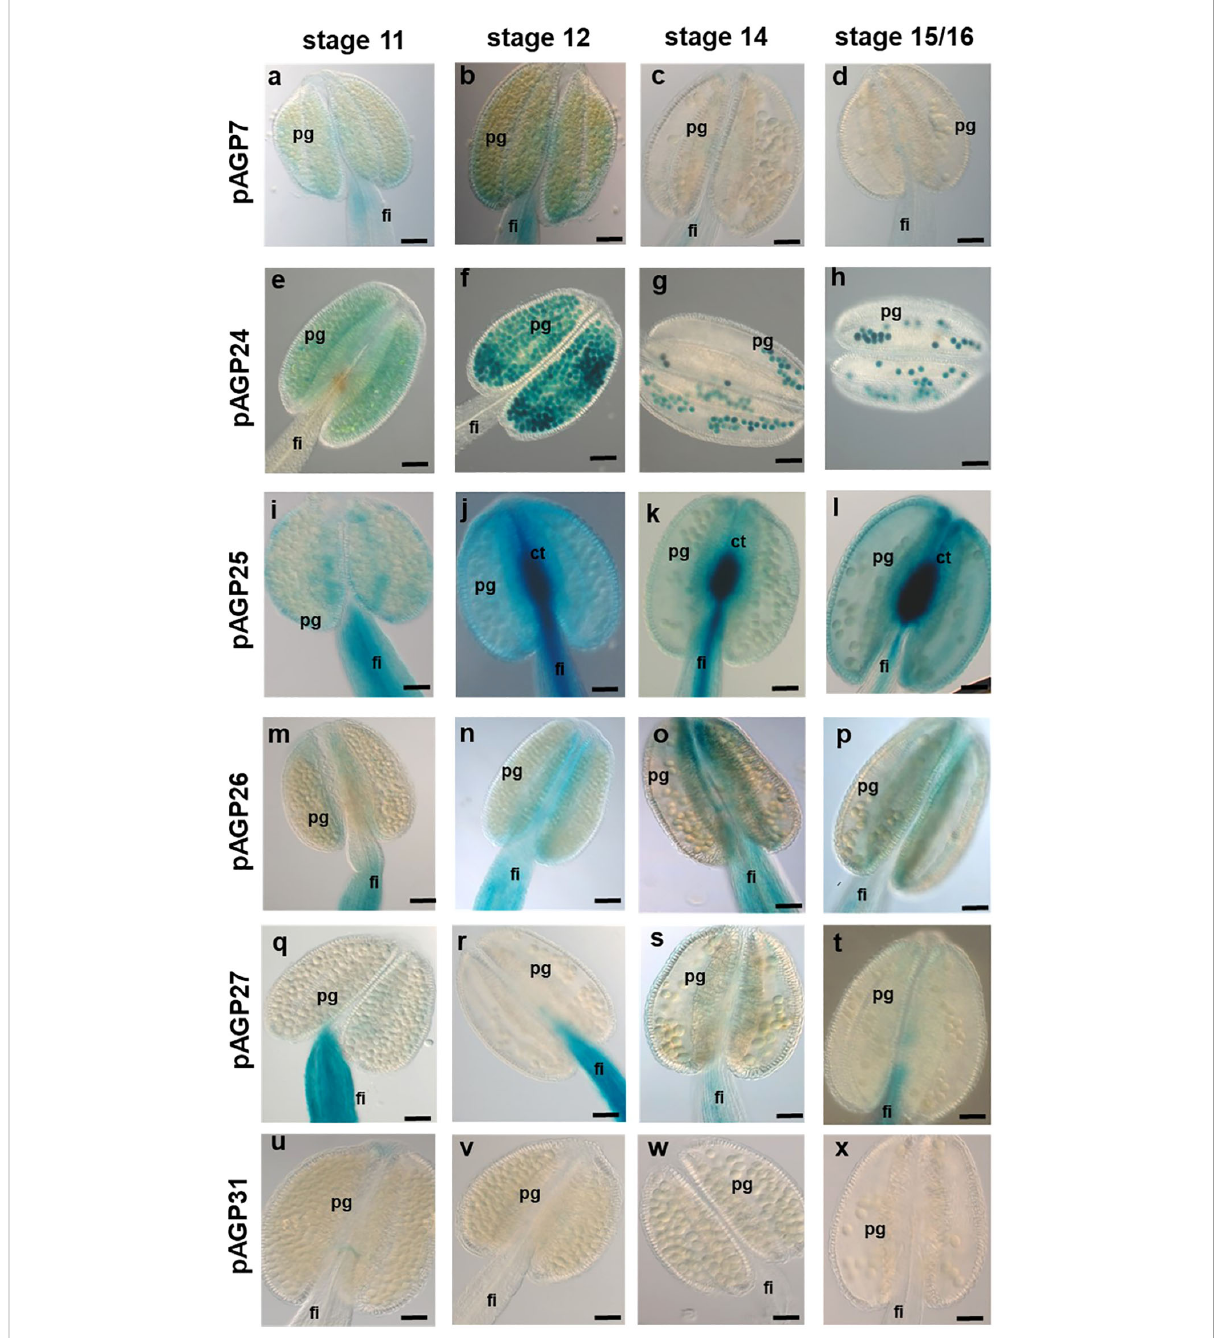
FIGURE 4 Histochemical localization of GUS activity in transgenic Arabidopsis anthers expressing different pAGP : GUS fusion constructs. (A – D) GUS activity driven by the AGP7 promoter at different stages detected only in the anther fi lament. (E – H) Strong GUS activity driven by the AGP24 promoter is detected in pollen grains at different stages. (I – L) GUS activity driven by the AGP25 promoter was identi fi ed in ovules, including the fi lament and connective tissue. (M – P) GUS activity driven by the AGP26 promoter at different stages was observed in anther tissues and fi lament. (Q – T) GUS activity driven by the AGP27 promoter visible only in the anther fi lament. (U – X) Absent GUS activity driven by the AGP31 promoter in anther tissues at different stages. Flowers of stages 11, 12, 14 and 15/16 (Smyth et al., 1990) were used in this study. ov, ovule; pg, pollen grain; pt, pollen tube; s, stigma; st, style; sp, septum; tt, transmitting tract; v, valves; ct, connective tissue. Scale bars, 50 m m (A – V, W, X)